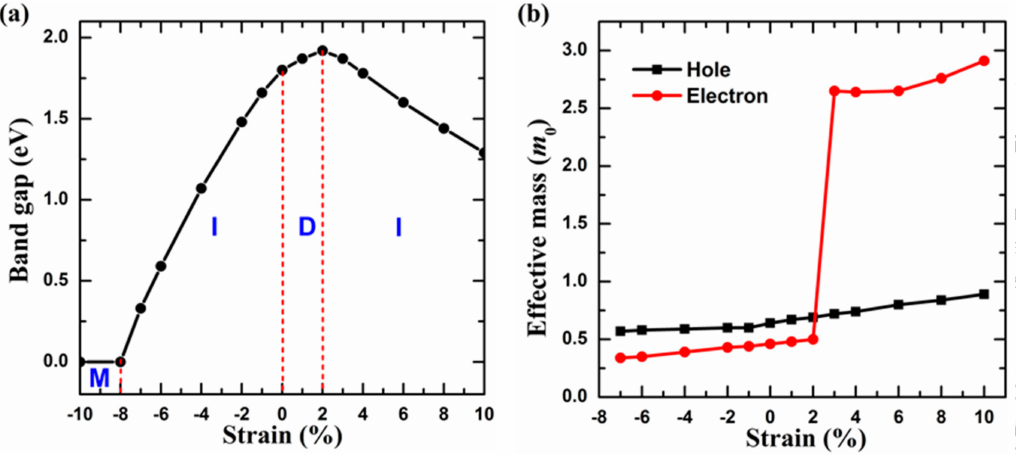
Figure 3. Strain effects on ( a ) the band gaps, and ( b ) the effective masses of 2D PC. In panel ( a ), M, I, and D represent the metal, indirect semiconductor, and direct semiconductor,